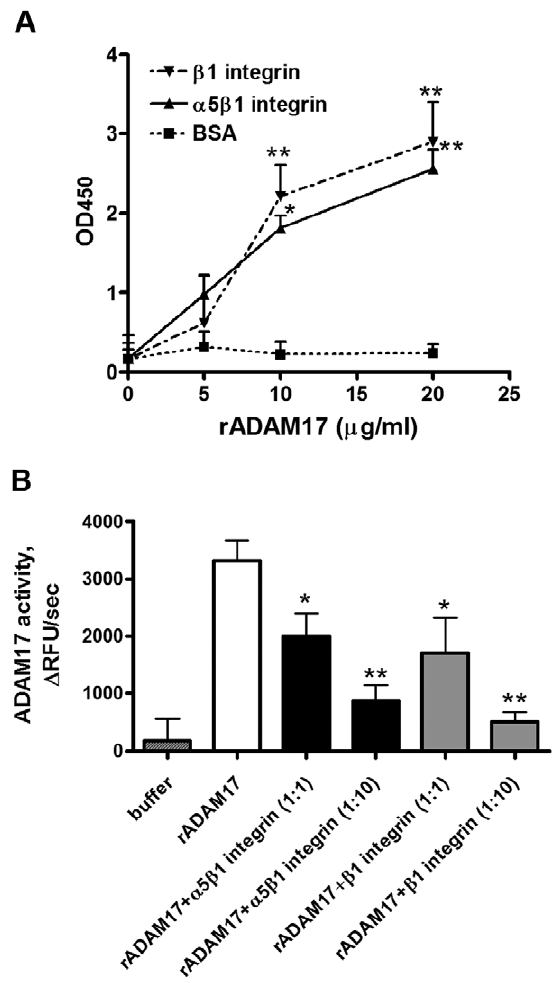
Figure 3. Cell free assays show ADAM17 binding to a 5 b 1 integrin and changes in ADAM17 activity. (A) Recombinant ADAM17 binds purified a 5 b 1 integrin and recombinant b 1 integrin in a cell free binding assay. Plates pre-coated with antibodies against a 5 b